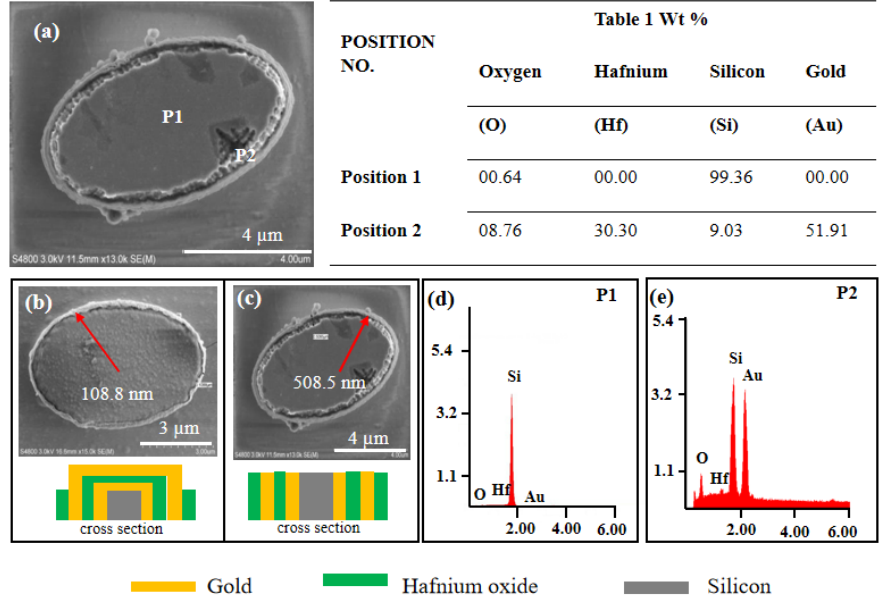
Figure 2. SEM images showing a top view of the Au NREs, ( a ) after all the wet-etching processes are complete, ( b ) width measurements of the outer layer thickness after removing the first HfO 2 layer. ( c ) width measurement of the outer layer thickness after the final fabrication process. ( d , e ) EDS plots quantifying the elemental composition of the silicon micropillar’s tip center (Position 1), tip edge that includes the two Au layers and two HfO 2 layers (Position 2). The table in the figure lists the elemental wt%’s in P1 and P2 separately.